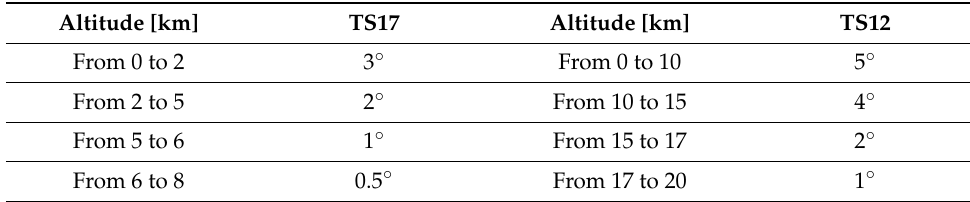
Table 3. Flight path angle included in the simulation. Altitude [km] TS17 Altitude [km] TS12 From 0 to 2 3 ◦ From 0 to 10